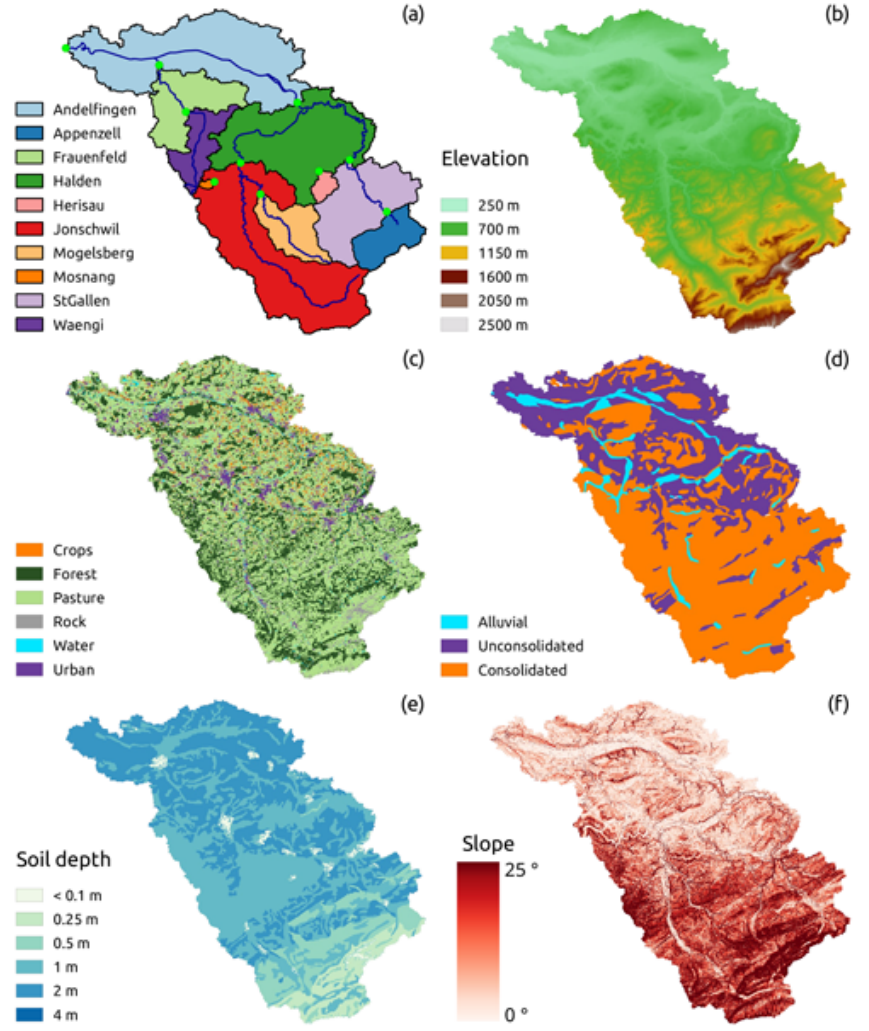
Figure 1. Landscape characteristics of the Thur catchment: (a) subdivision into subcatchments, river network, and gauging stations; (b) ele- vation map; (c) land-use map; (d) simplified geology map; (e) soil depth map; (f) slope map (derived from the elevation